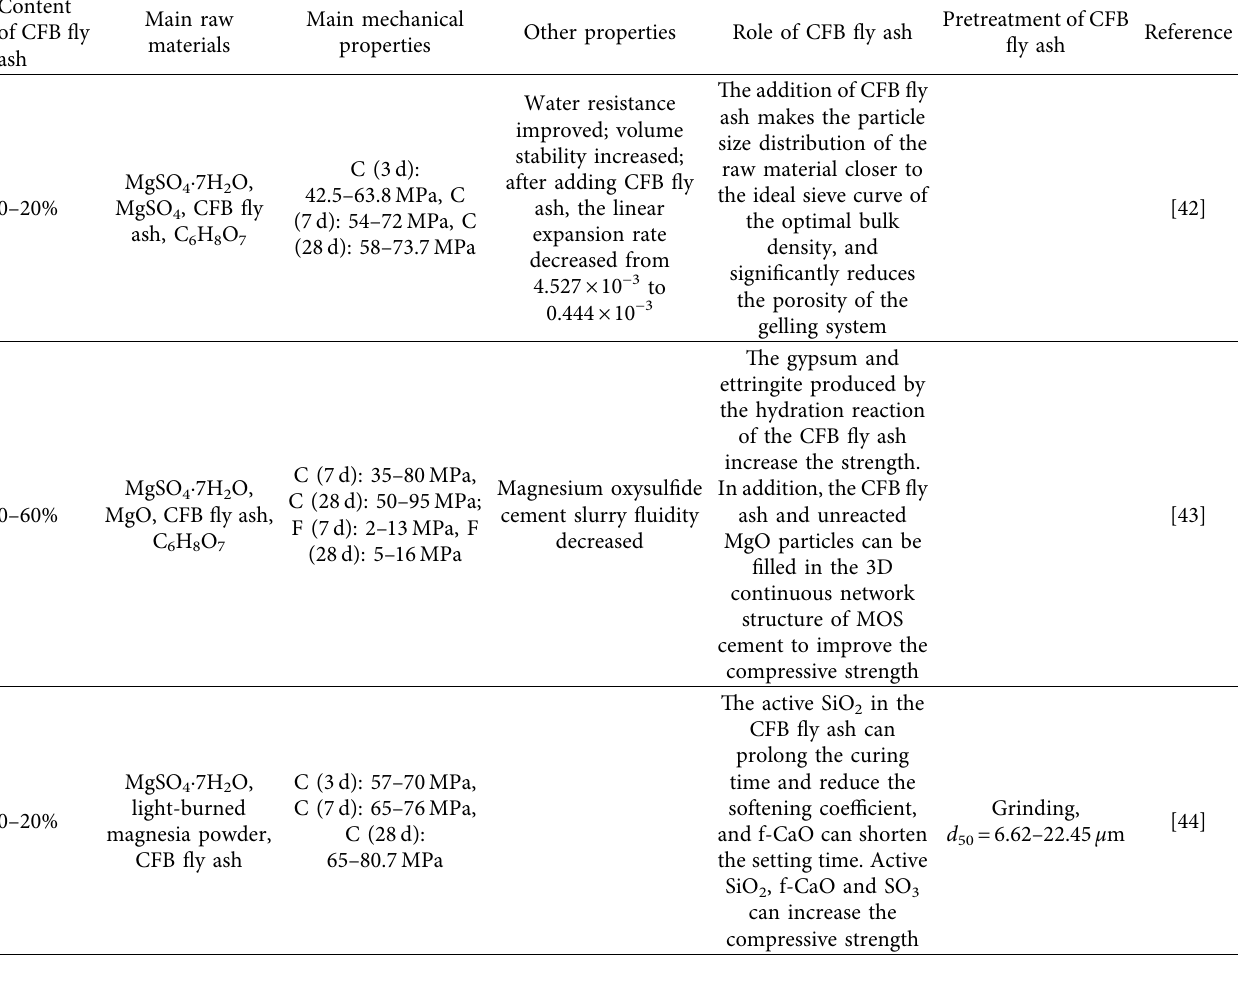
Table 3: Application of CFB fy ash in MOS cement.